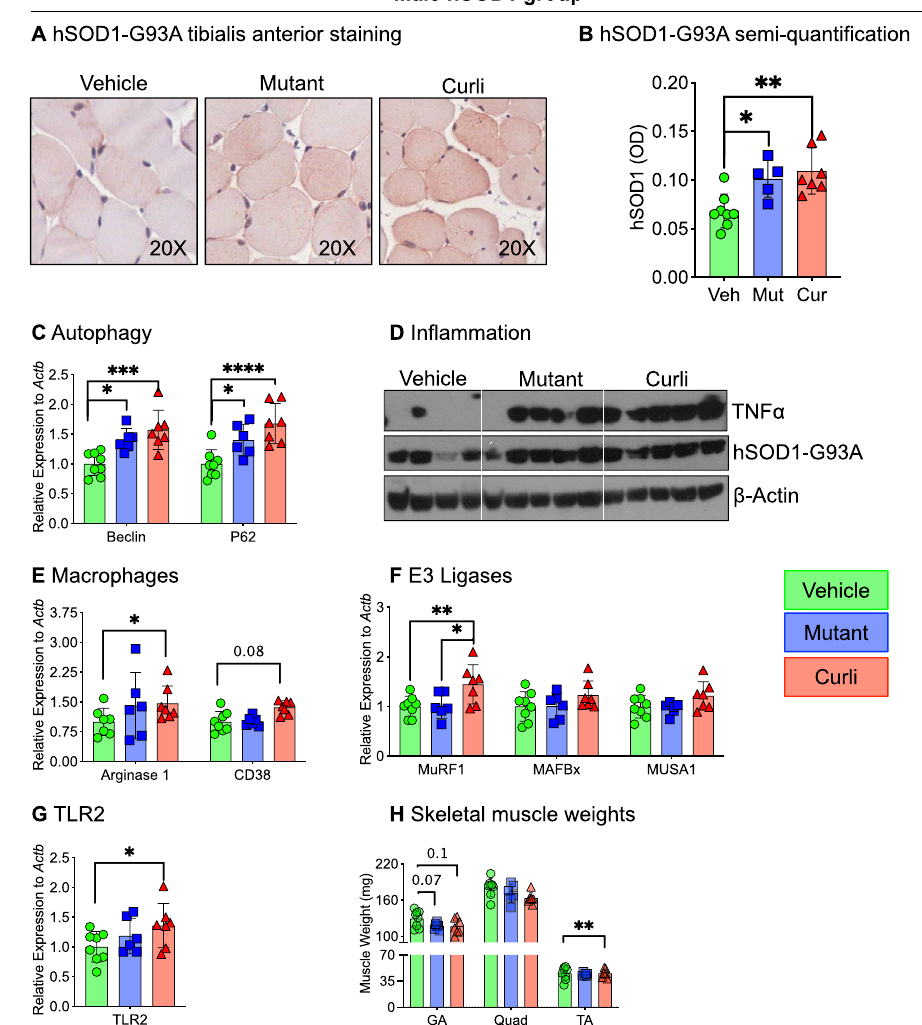
Figure 4. Markers of skeletal muscle atrophy by histochemical staining (tibialis anterior), Western blot analysis (gastrocnemius) and qRT-PCR (gastrocnemius) in the male hSOD1 group. ( A , B ) Mutant and curli-fed groups showed significantly increased immunostaining for hSOD1 in tibialis anterior muscles. Images were quantified in ImageJ utilizing optical density for positive staining. ( C ) qRT-PCR analysis demonstrated significantly increased expression of autophagy markers, Beclin and p62 mRNA in mutant and curli-fed mice compared to vehicle. ( D ) Western blot analysis showed increased expression of pro-inflammatory TNFα protein in mutant and curli-fed groups compared to vehicle. ( E ) Inflammatory macrophage populations M1 (CD38) and M2 (Arginase 1), were both significantly elevated in gastrocnemius of curli-fed mice compared to vehicle. ( F ) mRNA expression of an E3 ligase MurF1 was increased 1.5-fold in curli-fed male hSOD1 mice compared to mutant and vehicle groups. ( G ) mRNA expression of TLR2, a pathogen recognition receptor was significantly increased 1.4-fold in curli-fed group compared to vehicle. ( H ) Skeletal muscle weights of gastrocnemius (GA), quadriceps (Quad) and tibialis anterior (TA) were measured post-mortem and curli-fed mice had significantly lower weights of the tibialis anterior muscles compared to vehicle and mutant-fed groups. * p < 0.05, ** p < 0.01, *** p < 0.001, one or two-way ANOVA. n = 6–8 per